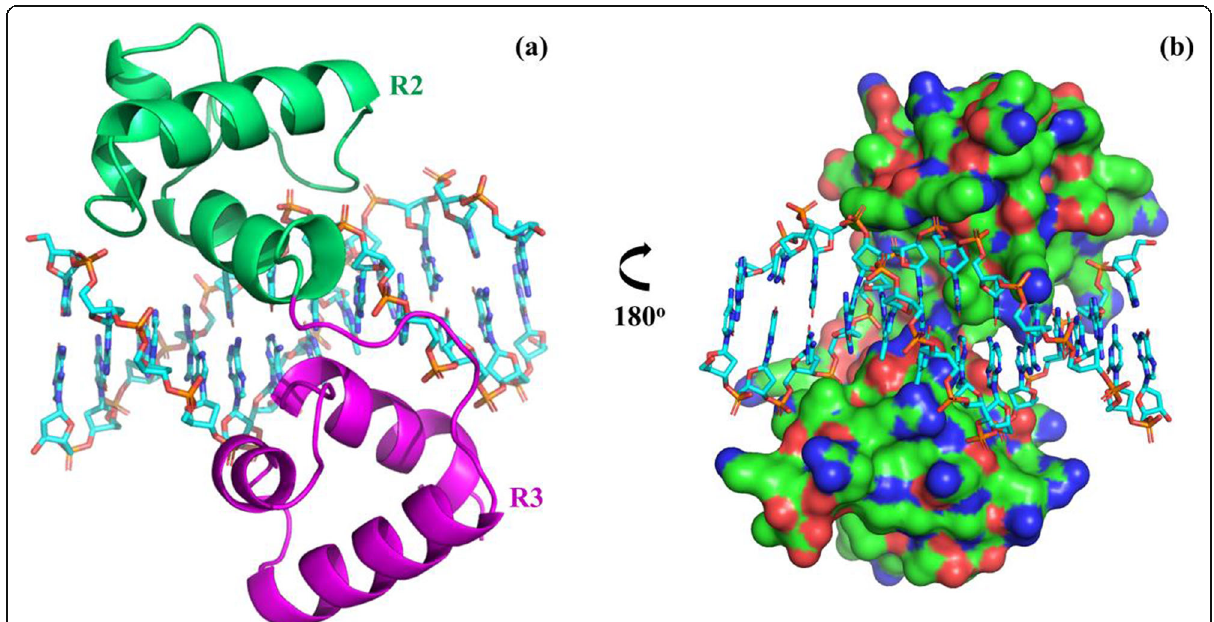
Fig. 3 Predicted structure of the OsMYB59 – DNA complex. DNAs are shown as sticks and OsMYB59 is shown as cartoon ( a ) and as an electrostatic surface potential map ( b